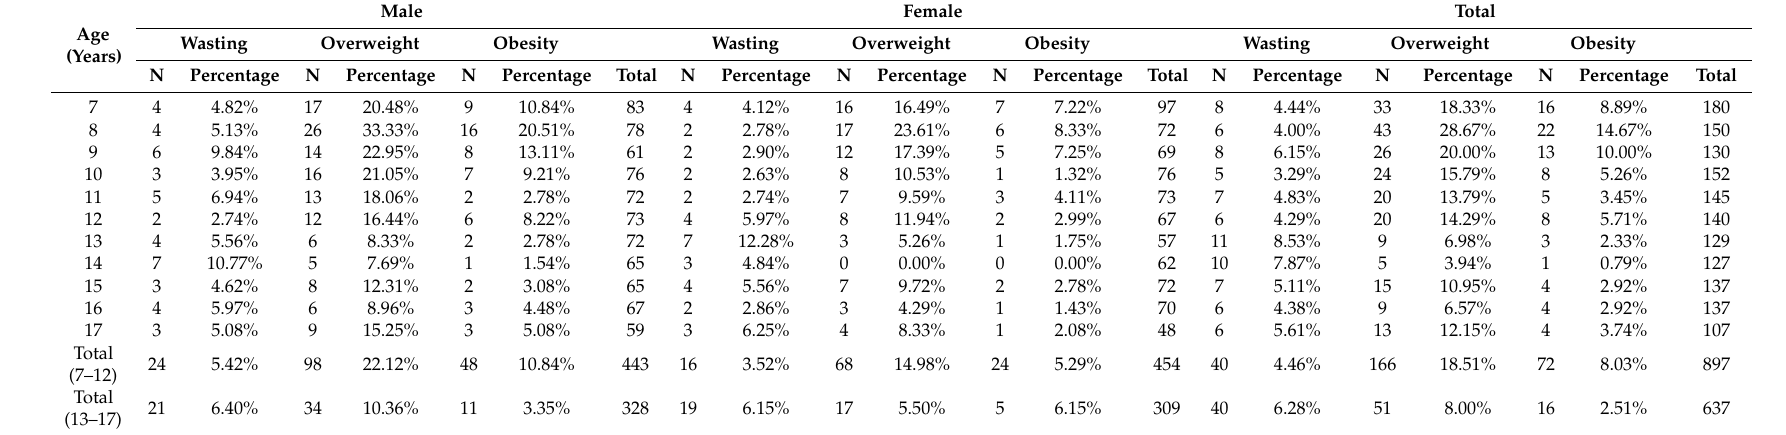
Table 2. The distribution of wasting, overweight and obesity in Zhejiang province stratified by age and gender.